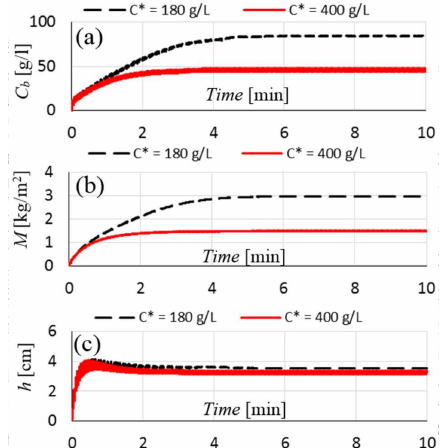
Figure 7. Main parameter configuration with a wave forcing of u b = 40 cm/s. Evolution of ( a ) near-bed suspended-sediment concentration, C b ; ( b ) total eroded sediment mass, M ; and ( c ) lutocline height, h = M / C for C * = 180 g/L (dashed black line) and C * = 400 g/L (solid red line).